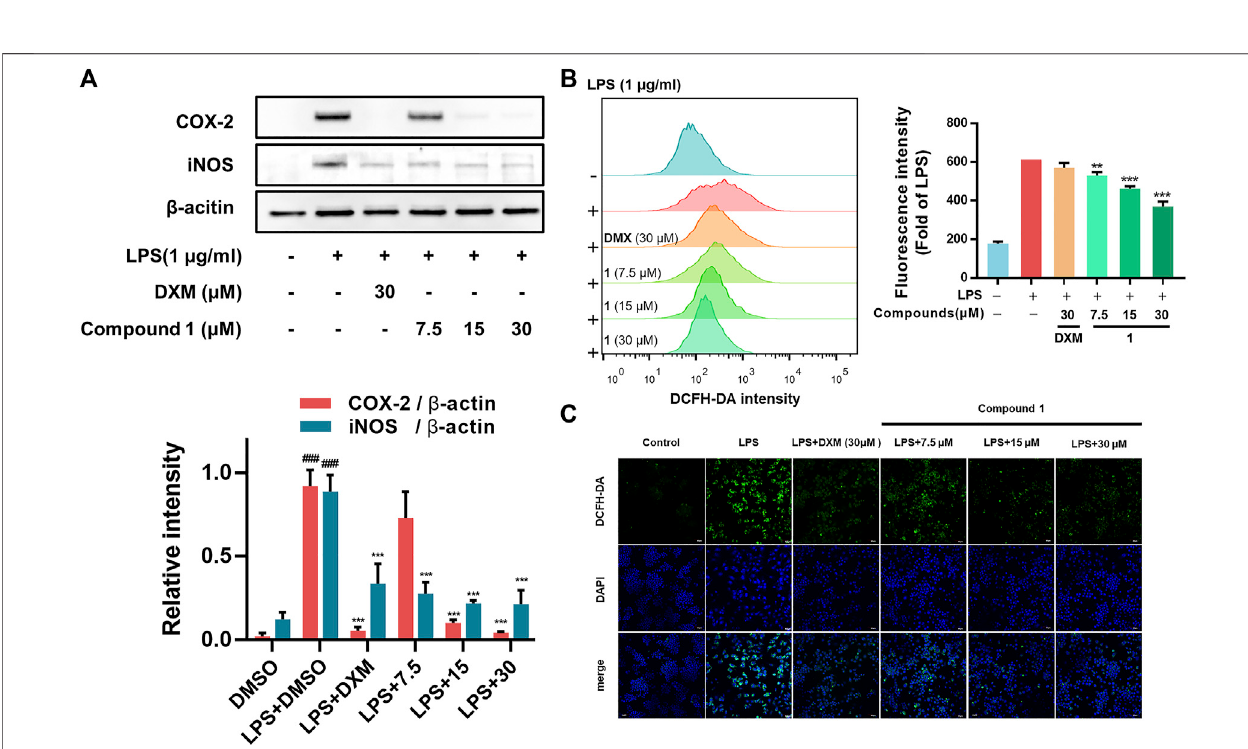
FIGURE 3 | (A) Effects of 1 on LPS-induced COX-2 and iNOS levels in RAW264.7 macrophages. RAW264.7 macrophages were pretreated with the tested compounds (7.5, 15, and 30 μ M) and dexamethasone (30 μ M) as the positive control (B) RAW264.7 macrophages were pretreated with 1 for 1 h and then exposed to 1 μ g/ml LPS for 24 h. Cells that were labelled with DCFH-DA were evaluated by fl ow cytometry. The geometric mean fl uorescence intensity is expressed as the mean ± SD. (C) The protective effect of 1 in LPS-treated RAW264.7 macrophages. Green fl uorescence indicating intracellular ROS stained by DCFH-DA. RAW264.7 macrophages were pretreated with 1 for 1 h and exposed to 1 μ g/ml LPS for 24 h. Data are expressed as the mean ± SD. ### p < 0.001, compared with the normal control group. ** p < 0.01, and *** p < 0.001, compared with the LPS group.